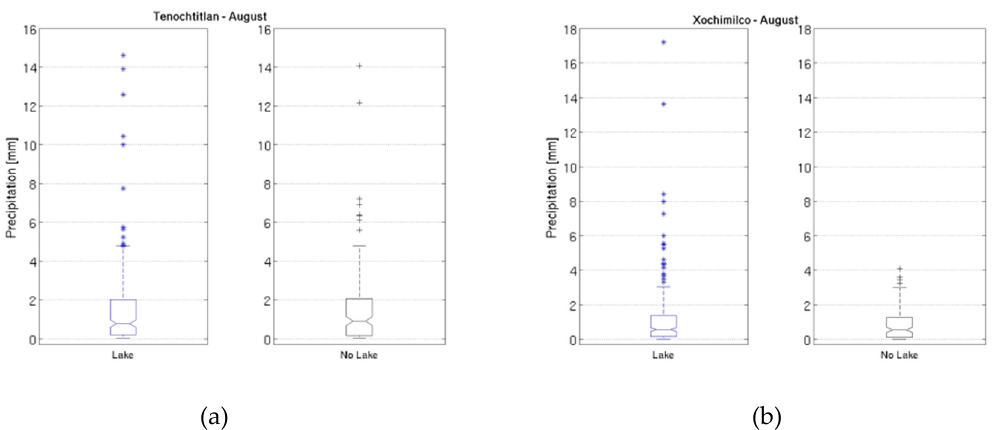
Figure 11. Box plots of the hourly precipitation (>0.005 mm/h) in Tenochtitlán ( a ) and Xochimilco ( b ) with L/WRFc (left) and with NL/WRFc (right) during the month of August. (No-Lake: NL/WRFc; Lake: L/WRFc.)